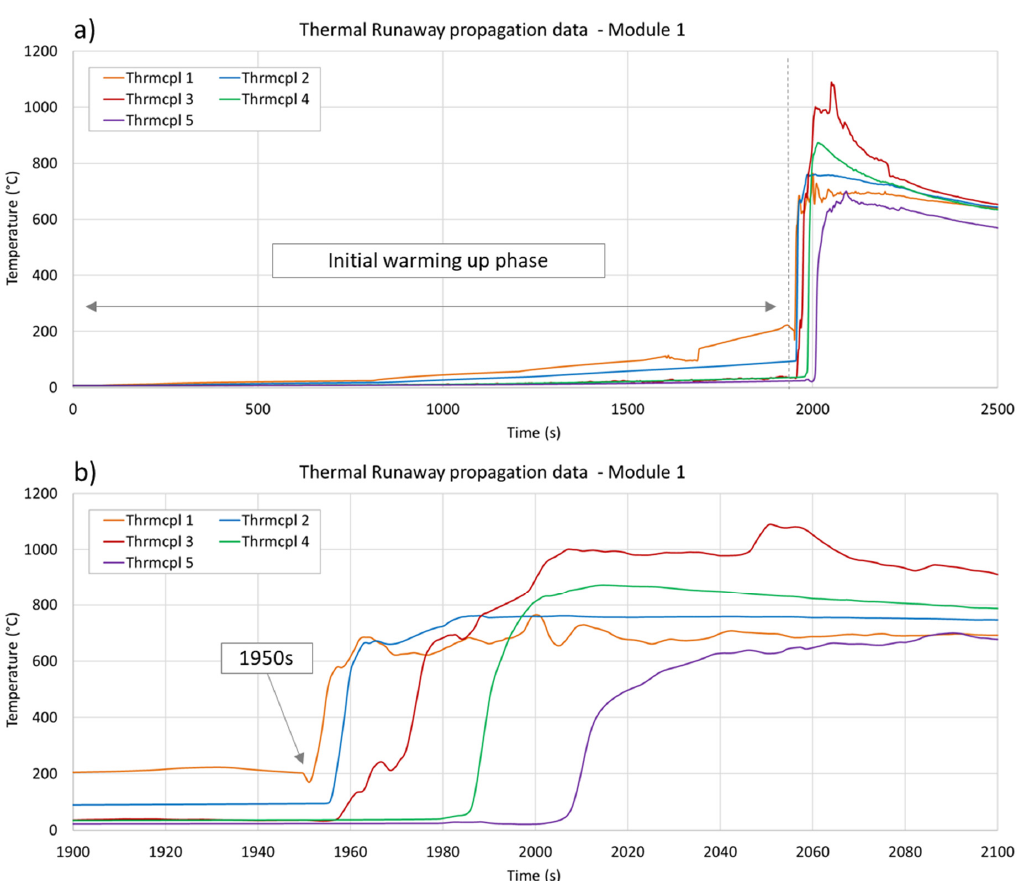
Figure 7. Plots of temperatures recorded by the 5 thermocouples for TR propagation test; ( a ) Overview of 5 temperature sensors; time window is set from beginning to end of experiment; ( b ) Zoom of time window where temperatures rise in correspondence to TR.